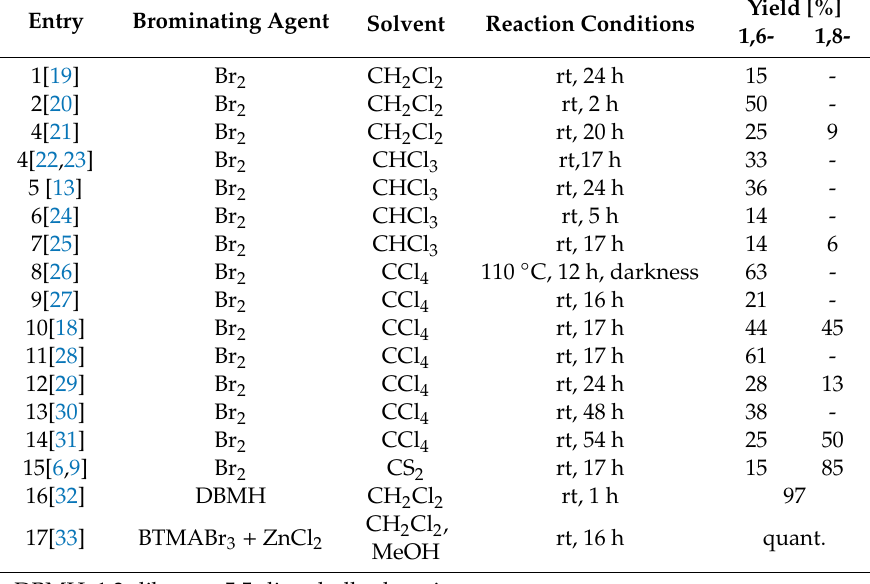
Table 1. The reported bromination reactions of pyrene.